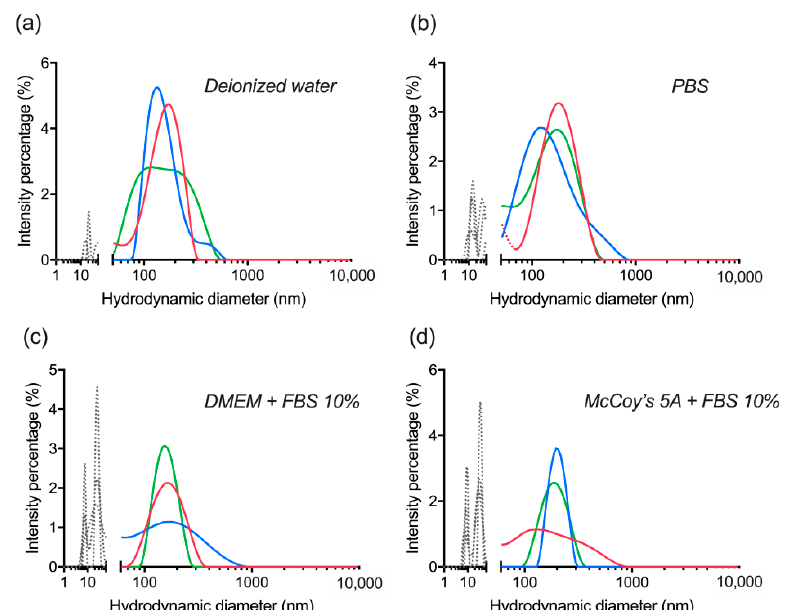
Figure 8. Evaluation of colloidal stability of lyophilized dBSA-UCNP-NOBF 4 in different buffers after one year of lyophilization and mixed by vortexing only, based on the results of three repeated size measurements (shown in blue, red, and green) by DLS: ( a ) in deionized water; ( b ) in PBS; ( c ) in DMEM cell culture medium supplemented with 10% FBS; ( d ) in McCoy’s 5A cell culture medium supplemented with 10% fetal bovine serum (FBS). Gray and/or dotted lines below 100 nm correspond to the presence of proteins and protein aggregates; dotted lines over 300 nm are aggregates.